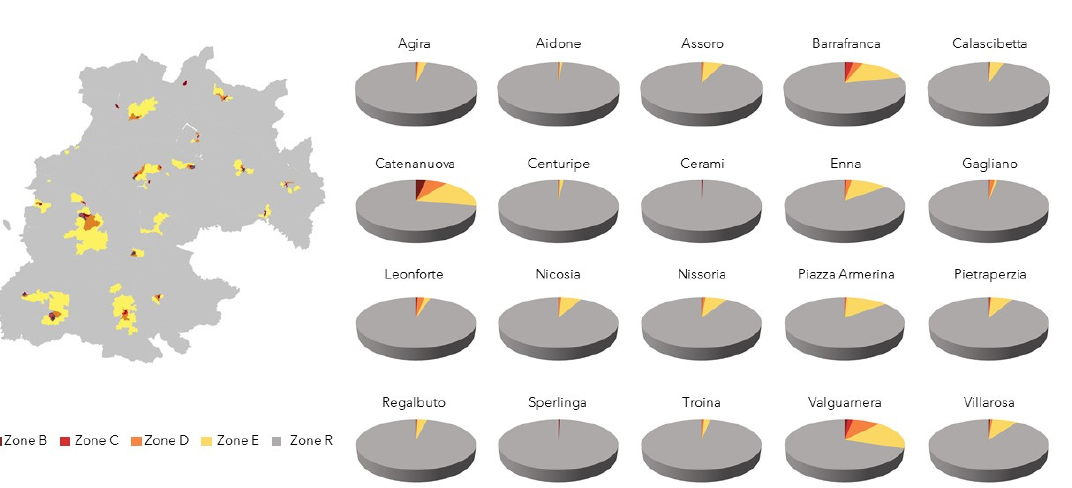
Figure 4. OIREM Micro-zone classification, and distribution of the urbanization of the municipality degree. An OMI zone is a territorial portion that reflects a homogeneous sector of the local housing market: B central, C semi-central, D peripheral, E suburban, R rural. The pie charts show the percentages of the OIREM Micro-zone in the municipal areas.